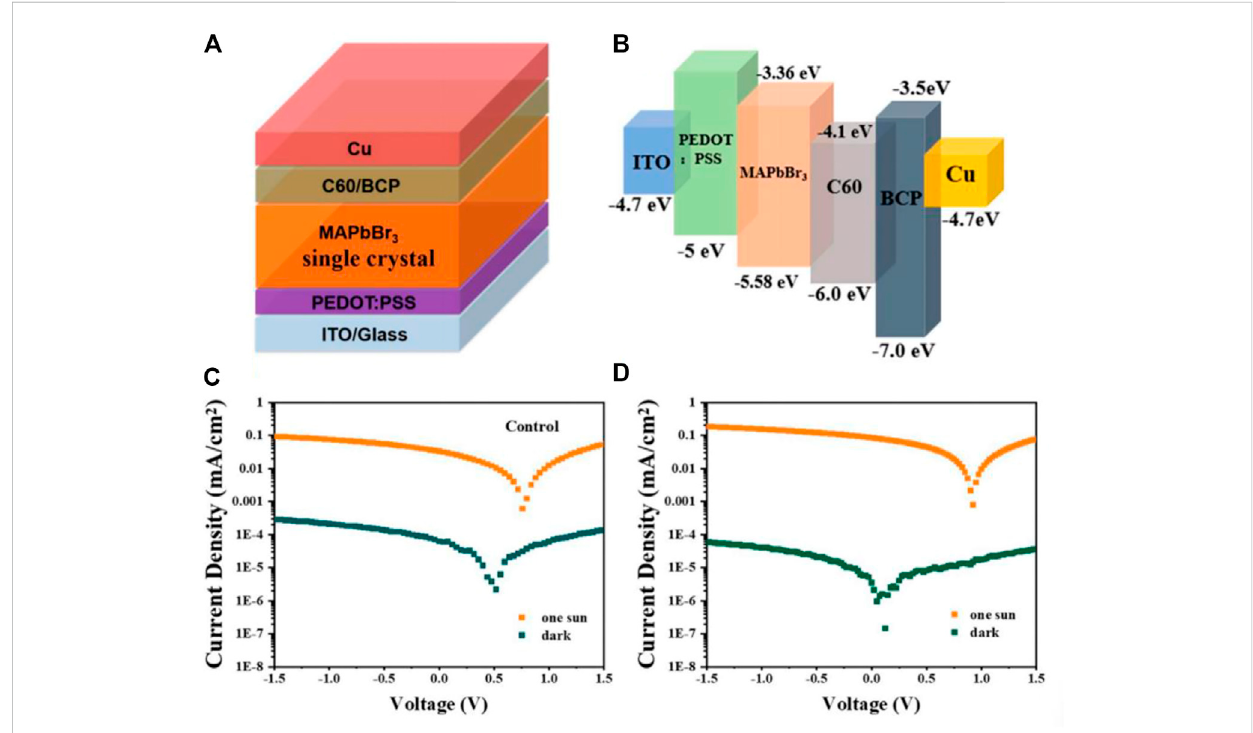
FIGURE 6 (A) Schematicdiagramand (B) energylevelofdetectorbasedonITO/PEDOT:PSS/singlecrystals/C 60 /BCP/copper(Cu). (C) WithandwithoutO 3 -UV treated detector under dark and AM 1.5 illumination. Reproduced with permission from Ref. [44] (A) (B) (C) (D)